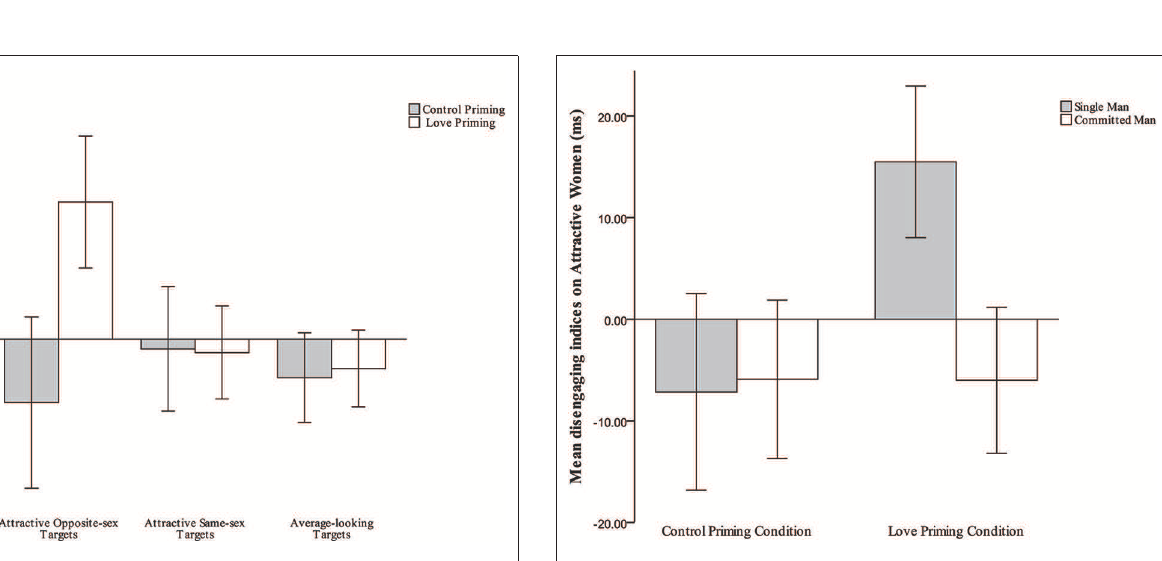
Love Scale score as covariates, the three-way interaction effect was not significant, F (2,106) = 0.007, p = 0.993, no other significant effects were observed (all ps > 0.699), and the same 2 (priming condition) × 3 (target type) repeated-measures